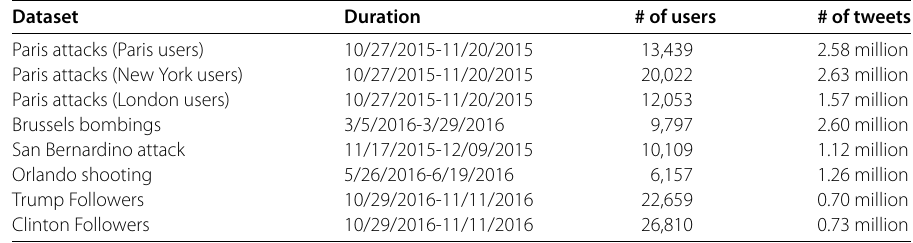
Table 1 Datasets used in this study Dataset Duration # of users # of tweets Paris attacks (Paris